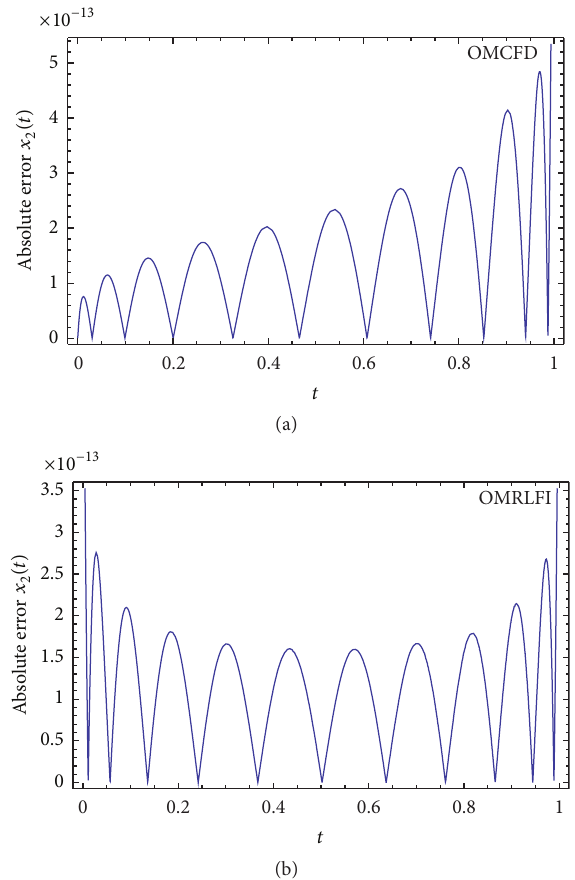
Figure 8: Plot of absolute error function 𝑥 2 (𝑡) for 𝛼 1 = 𝛼 2 = 1 and 𝑚 = 10 by OMCFD and OMRLFI in Example